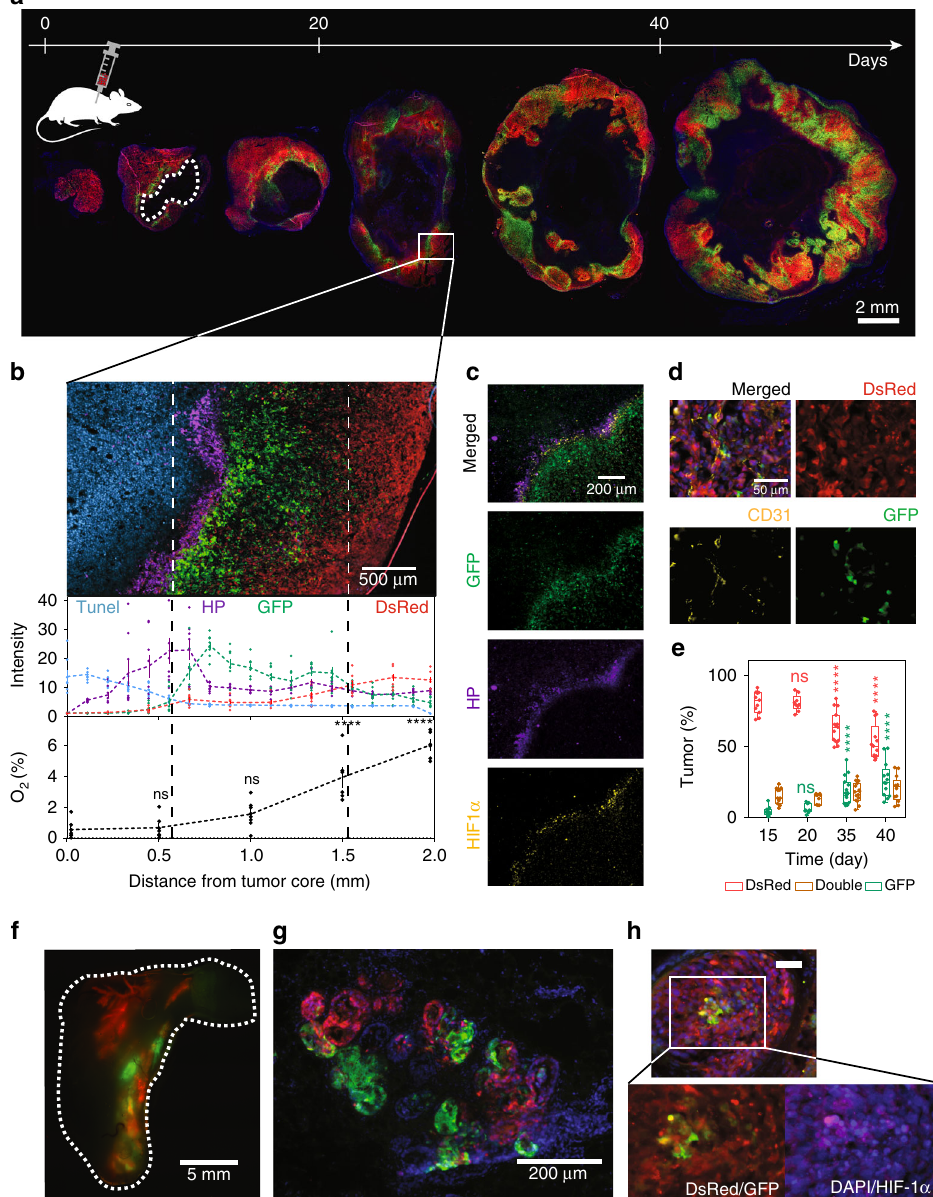
Fig. 4 Implementing a hypoxia fate-mapping system in breast cancer models. a Fluorescent images of full cross sections of orthotopic mammary tumors derived from MDA-MB-231 hypoxia fate-mapping cells. Tumors were excised at various times over a 45-day period and sectioned for imaging. The white dashed line outlines the necrotic core. b Fluorescent images of DsRed and GFP expression, and TUNEL (blue) and Hypoxyprobe ™ (purple) labeling. Normalized intensity plots for each fl uorophore (top) (mean ± SEM, n = 8), or O 2 measurements (bottom) are displayed as a function of distance from the tumor core. O 2 measurements were performed by using a fi xed-needle microprobe (mean ± SEM, N = 8; **** P < 0.0001 vs. 0 (one-way ANOVA with Bonferroni posttest). c Fluorescent images of GFP expression and Hypoxyprobe ™ (purple) and HIF-1 α (yellow) immuno fl uorescent labeling. d Fluorescent images of DsRed and GFP expression, and CD31 (yellow) immuno fl uorescent labeling to detect endothelial cells lining blood vessels in a tumor region far from the necrotic core. e Full tumor cross sections were imaged in tiles, linearly stitched, binarized by ImageJ, and used to determine the ratio of DsRed-, double- (both DsRed and GFP), and GFP-positive areas of MDA-MB-231 orthotopic tumors (see Supplementary Fig. 5b for an illustration of the calculation method). Ratios (%) are displayed in the graph at different time points of tumor progression (mean± SEM, N = 3, n = 48); **** P < 0.0001 versus day 15 (Two-way ANOVA with Bonferroni posttest). The box extends from the 25th to 75th percentiles, the median is marked by the vertical line inside the box, and the whiskers represent the minimum and maximum points. f MCF7 hypoxia fate-mapping cells were injected into the nipple and delivered to a single ductal tree of multiparous NSG mice. A whole mount of the mammary fat pad was imaged by fl uorescent microscopy 60 days after injection. g Tissue sections were stained with DAPI to detect cell nuclei and imaged for DsRed and GFP. h Tissue sections were stained with DAPI to detect cell nuclei and labeled with a HIF-1 α antibody. Scale bar: 50 μ